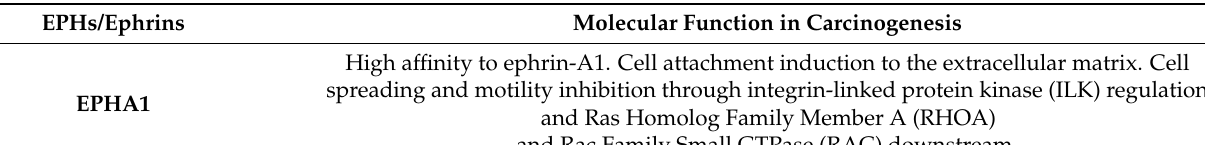
Table 1. Molecular function of EPH/ephrin genes and proteins in carcinogenesis [13]. EPHs/Ephrins Molecular Function in